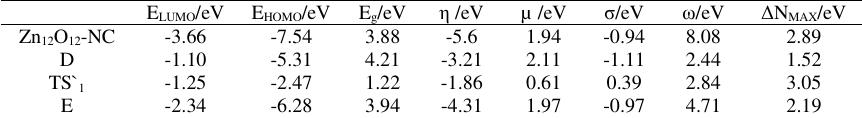
Table 5. DOS calculations for the NO 3- ion and the nano-adsorbents optimized by the B3LYP/6-31+G* computational method.